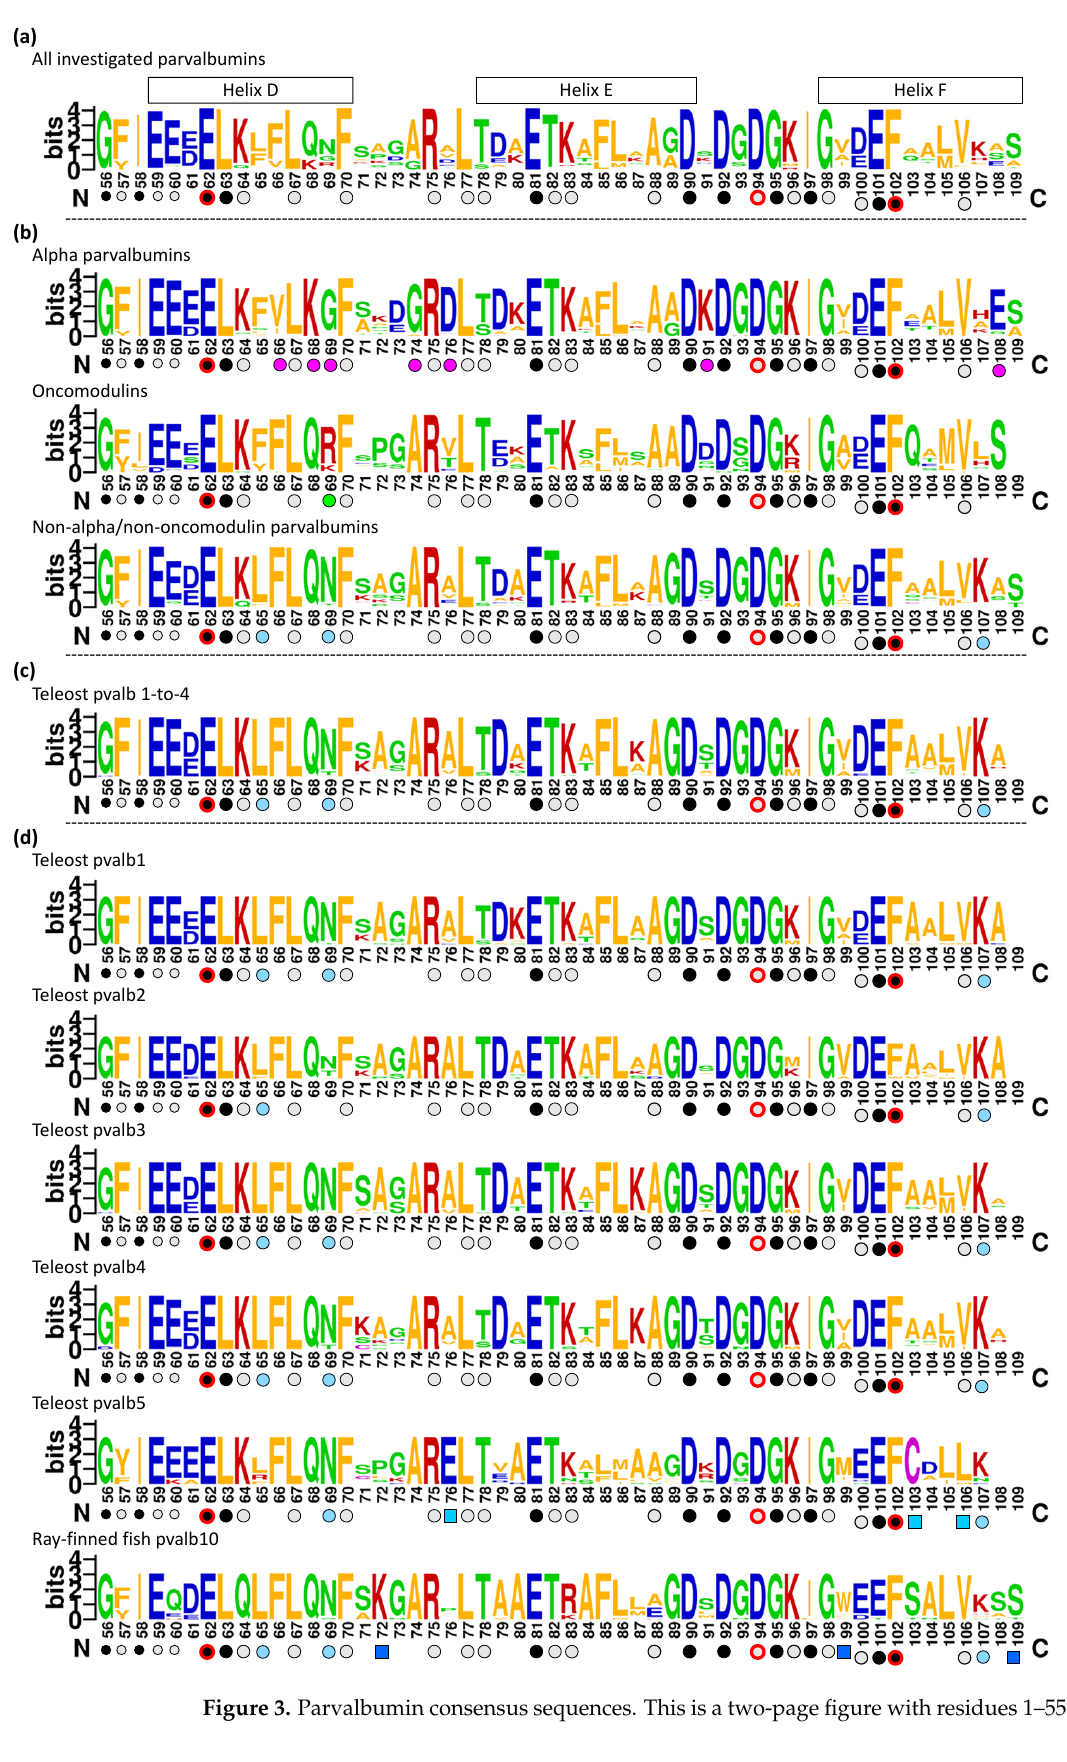
Figure 3. Parvalbumin consensus sequences. This is a two-page figure with residues 1–55 ( a – d